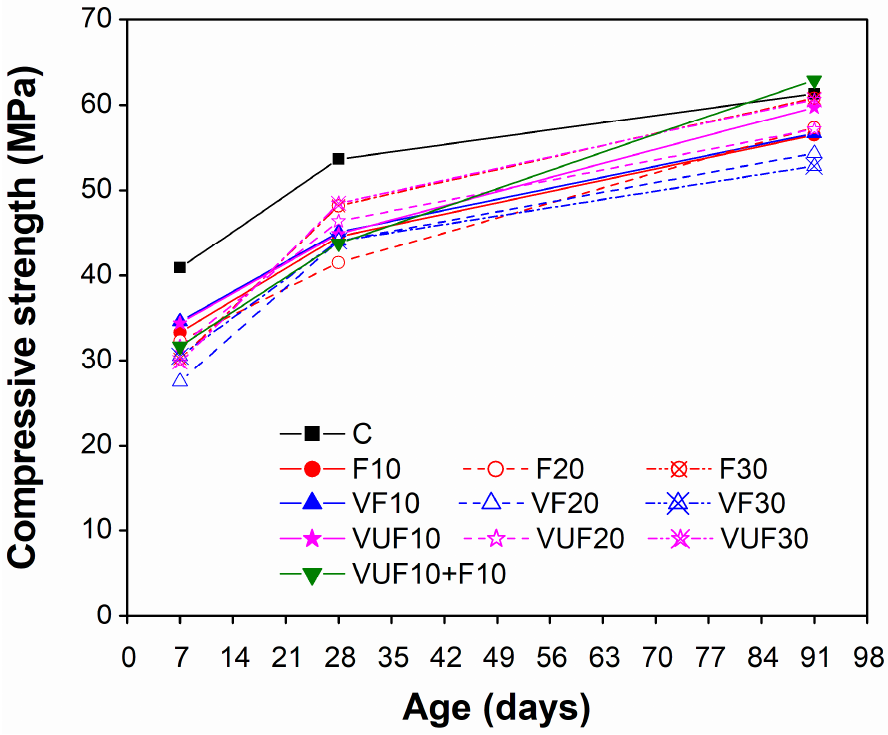
Figure 7. Comparison of compressive strength between control mortar and mortars containing different percentages of pozzolanic